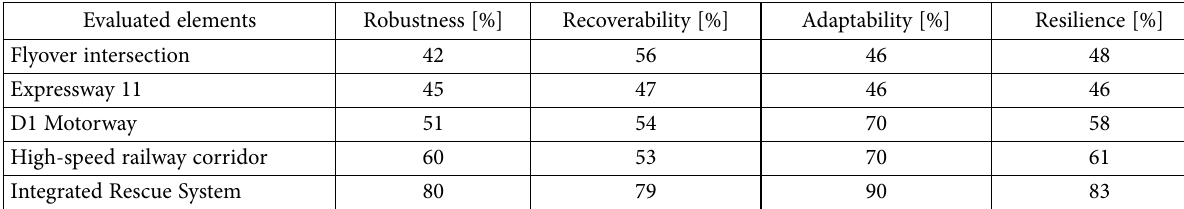
Table 7. Calculated level of resilience of evaluated elements Evaluated elements